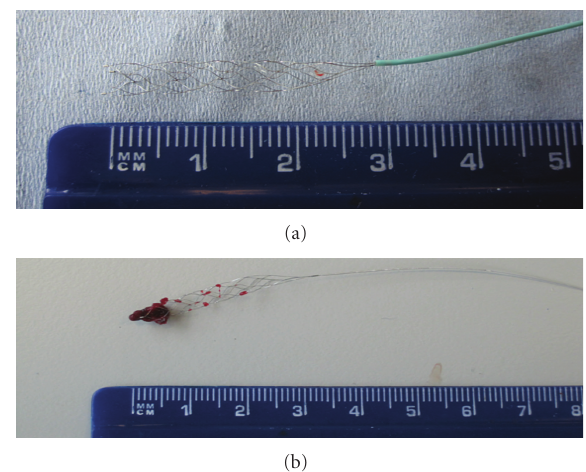
Figure 5: Solitaire AB Device expanded (a) and after clot retrieval